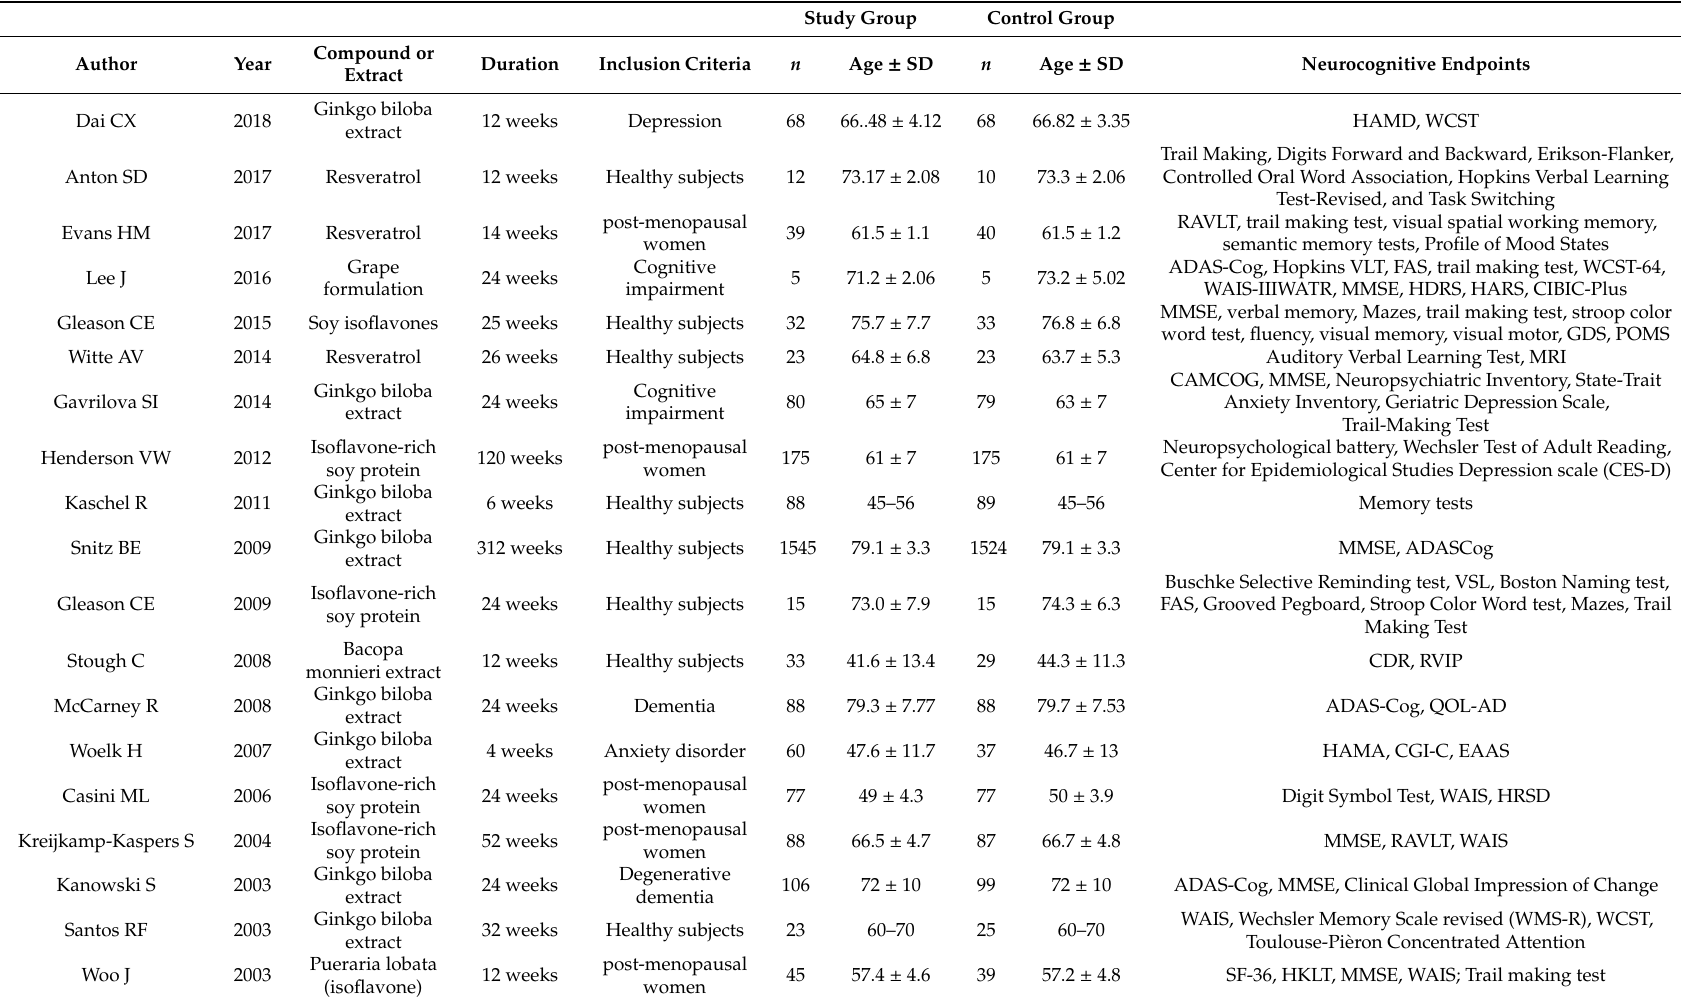
Table 2. Study characteristics after search for neurocognitive e ff ects. Study Group Control